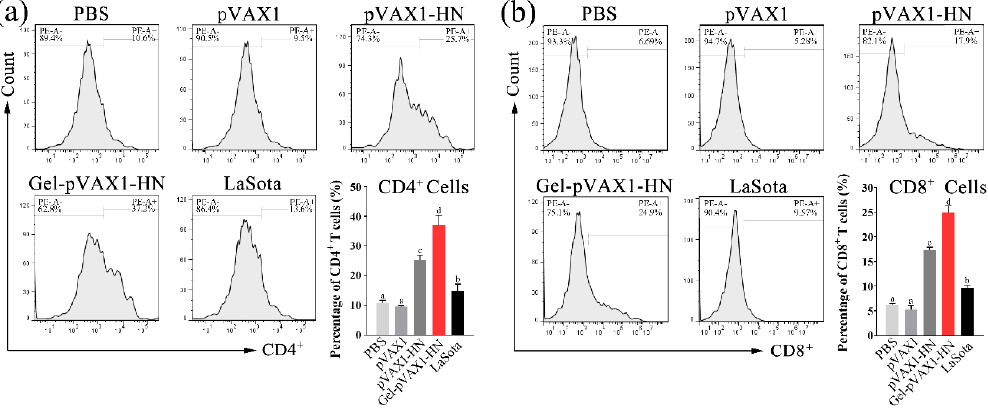
Figure 6. The percentages of CD4 + T cells ( a ) and CD8 + T cells ( b ) of peripheral blood lymphocytes. At the third week after immunization, the peripheral blood lymphocytes were isolated and stained with the CD4-PE or CD8-PE antibodies then counted by flow cytometry. The results are expressed as the mean ± SD of three independent experiments. Bars with different superscripts mean significant differences ( p < 0.05).